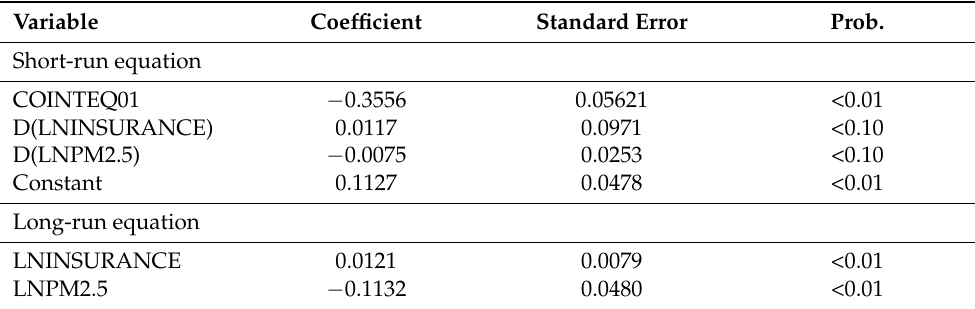
Table 5. Panel autoregressive distributed lag (ARDL) test (dependent variable log